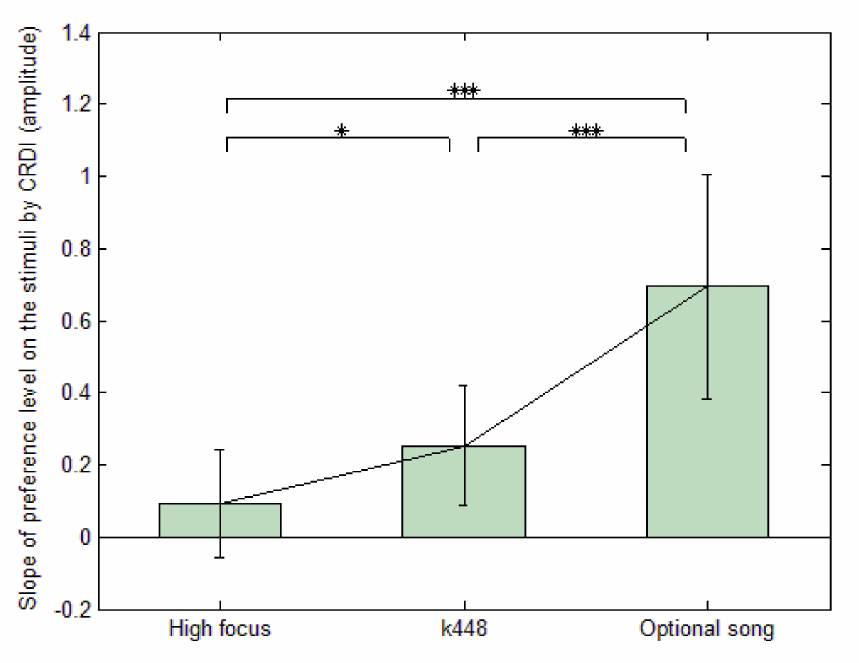
Figure 3. The slope and average preference level that the subjects rated for high focus music (HF), Mozart K.448 (K448), and favourite song (FS) by continuous response digital interface (CRDI), analysed by ANOVA; *: p < 0.05; ***: p <